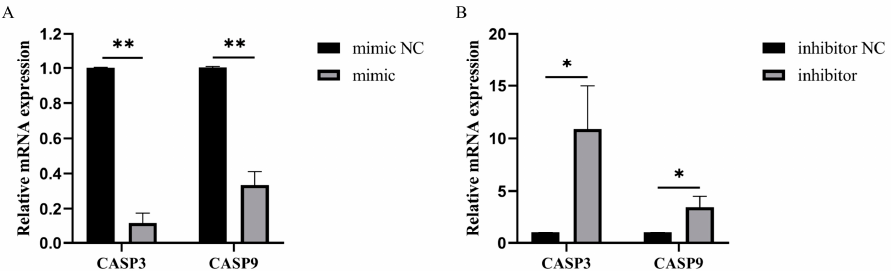
Figure 5. Effect of bta-miR-199a-3p on LPS-induced apoptosis gene expression in MAC-T cells. ( A , B ) After transfection with the bta-miR-199a-3p mimic or inhibitor, the mRNA expression levels of CASP3 and CASP9 in the LPS-treated MAC-T cells were detected using qRT-PCR. The GAPDH and RPS18 genes were used as the internal controls. * refers to p < 0.05, ** refers to p <